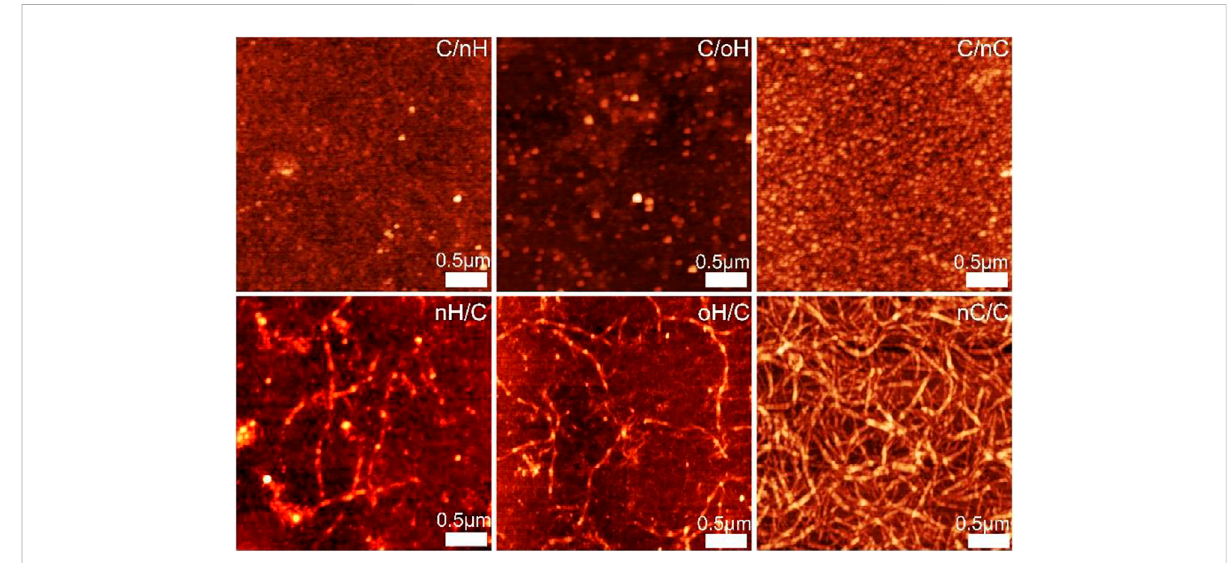
FIGURE 2 AFM images of polyanion (nHA, oHA, and nCS) terminal layers and outermost Col I for the different PEM. Scan size of all the images is 3 × 3